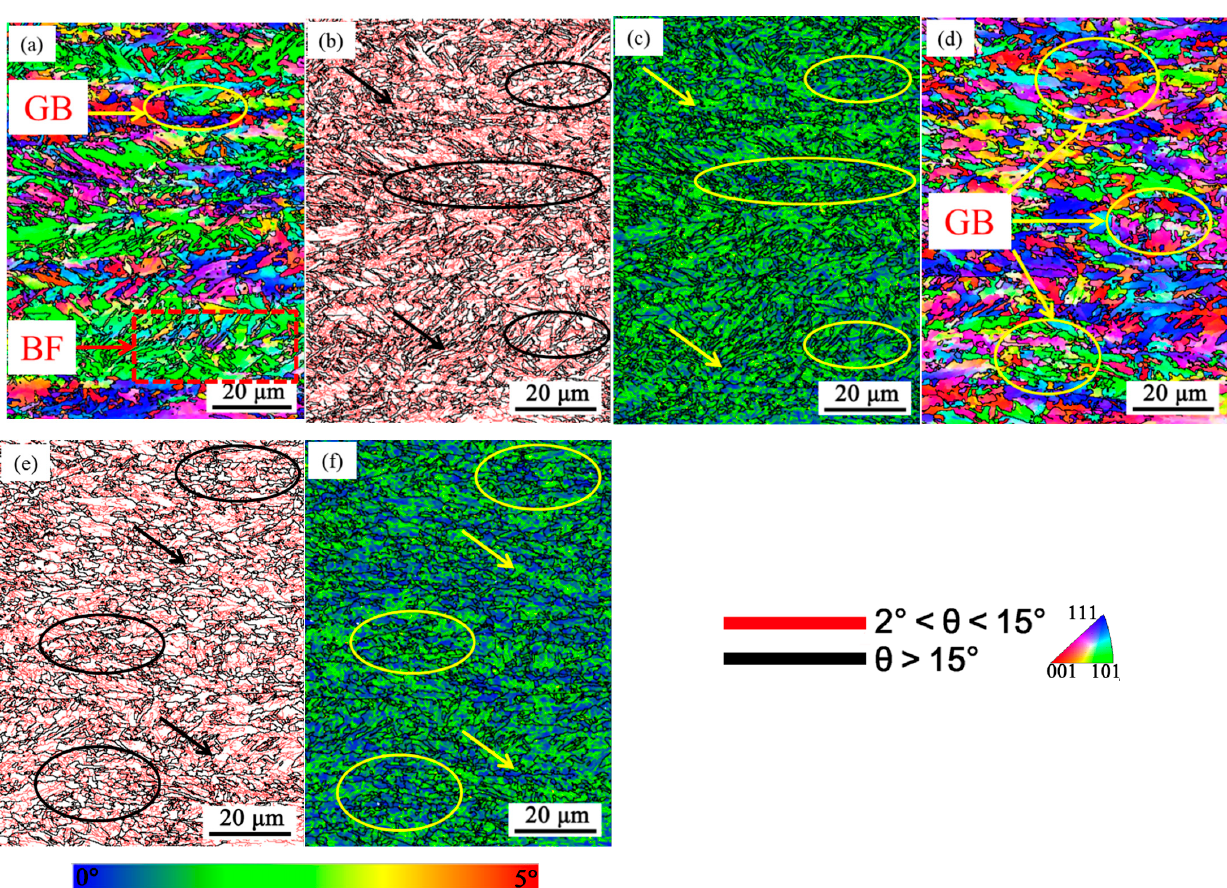
Figure 2. EBSD Figures of the rolling direction and 30° direction of X100 pipeline steel: ( a , d ) IPF diagram; ( b , e ) Large and low angle grain boundary diagrams; ( c , f ) KAM diagram.